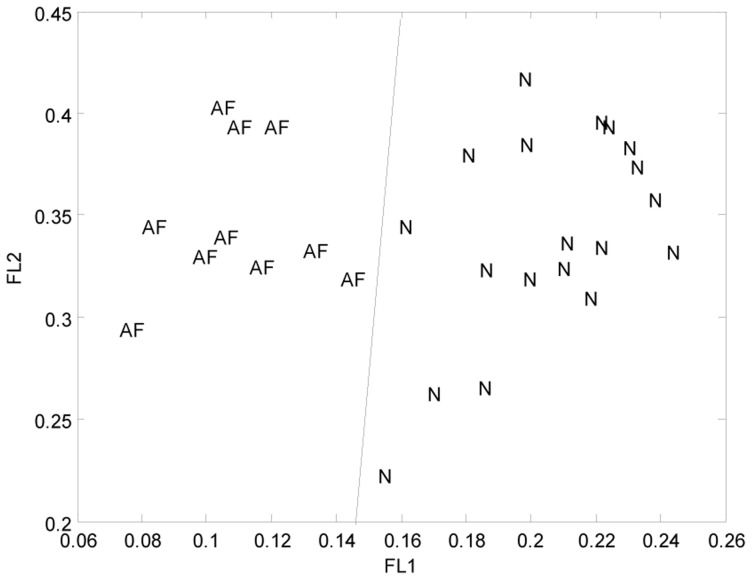
The classification results for the 29 samples by the first two PCs, where AF and N respectively indicate the pmAF and normal patients; The factor loading (FL) of a PC is defined as the correlation coefficients between original sample variables and this PC.FL1 and FL2 respectively denote the factor loadings of the first PC and the second PC on the 29 samples.